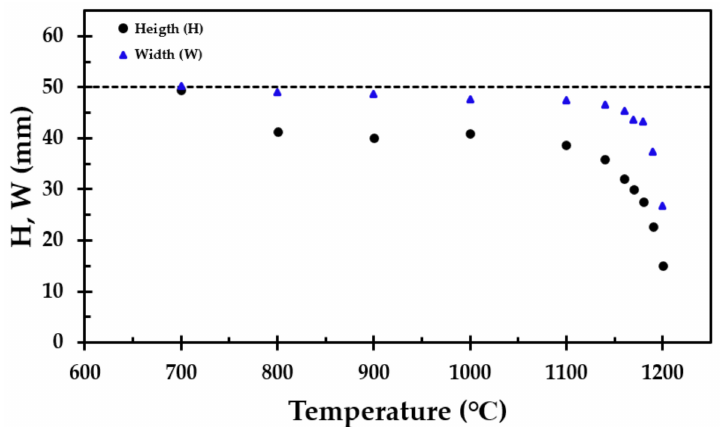
Figure 5. Height (H) of the test specimen ( ) and width (W) of the test specimen ( ) after the heat treatment. The height and the width are the average value of three measurements at each side of each of the four vertical faces.